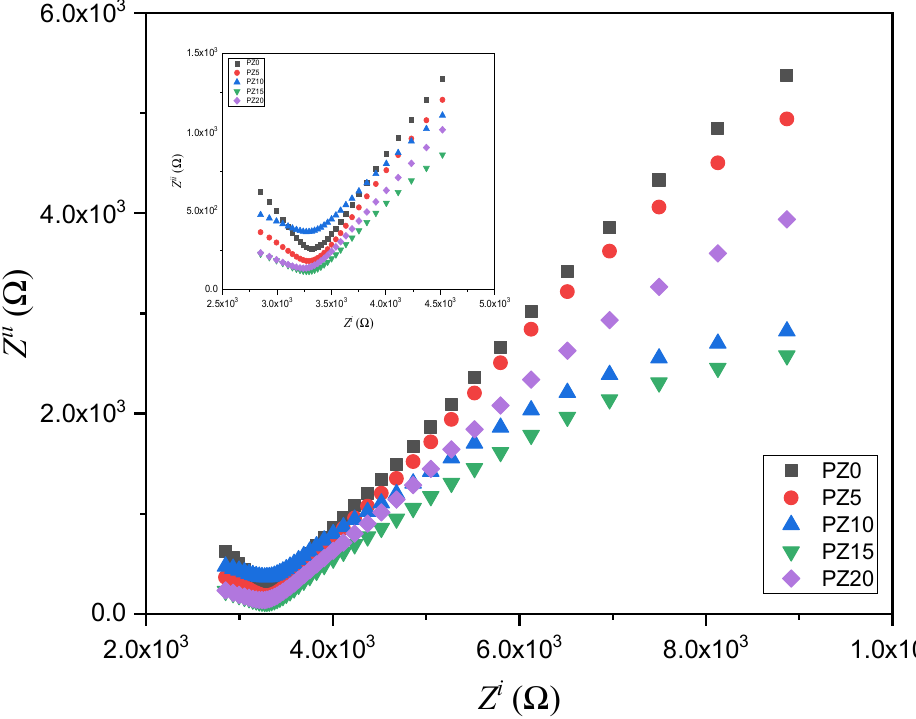
Figure 7. Cole–Cole plots for the PVA–CA–K 2 CO 3 /ZnO-NPs SPE composites at room temperature. The semicircle shown in the high-frequency region indicates double-layer capaci- tance at the electrode–electrolyte interface owing to the ion migration, whereas the low- frequency spike was ascribed to the ion absorption, which indicates the capacitive nature of the electrolytes [50]. Nevertheless, it could be observed that the semicircle of the sam- ples decreased with the successful incorporation of ZnO-NPs, which is attributed to a rise in the amorphous phase within the polymer, as well as due to the low T g value, which leads to an increase in the electrochemical performance of the electrolytes [43,51]. The nar- row semicircles with a tilted spike in the low- and high-frequency region in the Cole–Cole plots indicate that the samples contain mainly contain the resistive component [51]. The resistance is calculated from intercepts on the x-axis of the complex impedance plots. This